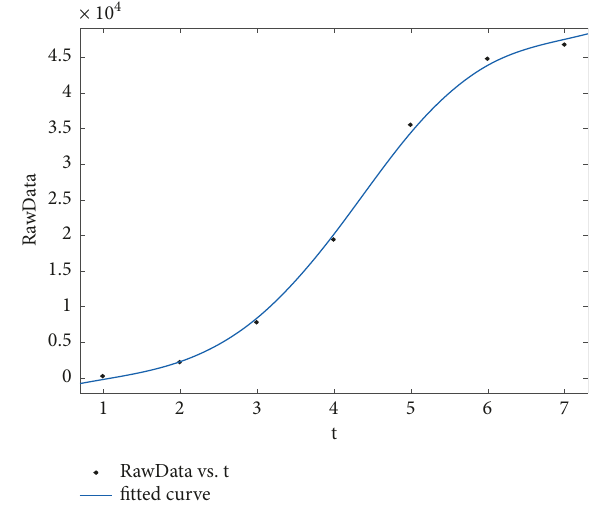
Figure 2: Cumulative cases of Ghana’s COVID-19 from March to September 2020 with the best-fitted